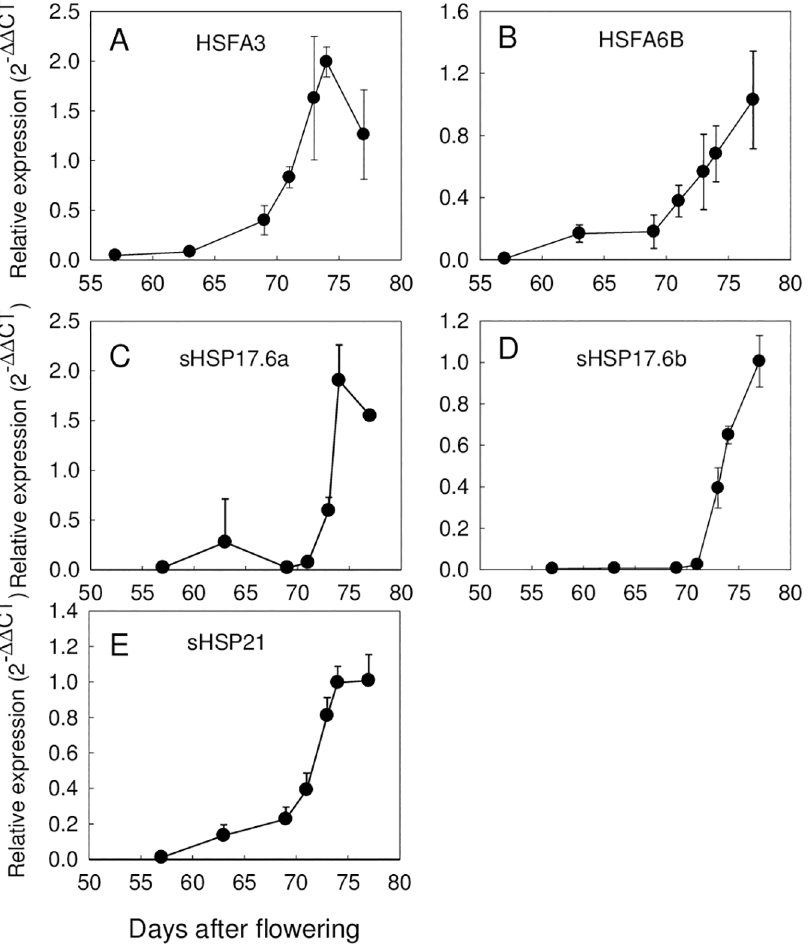
Fig 7. qPCR analysis of selectedgenes during seed maturation validates RNA-Seq data. (A) Heat shock transcription factor A3 (HSFA3: Glyma.03g191100);(B) Heat shock transcription factor A6B (HSFA6B: Glyma.03g157300);(C) sHSP17a (Glyma.17g224900);(D) sHPS17b (Glyma.14g099900), (E) sHSP21 (Glyma.08g318900).Data ( ± SE) are the averageof three biologicalreplicatesof 30 seeds.